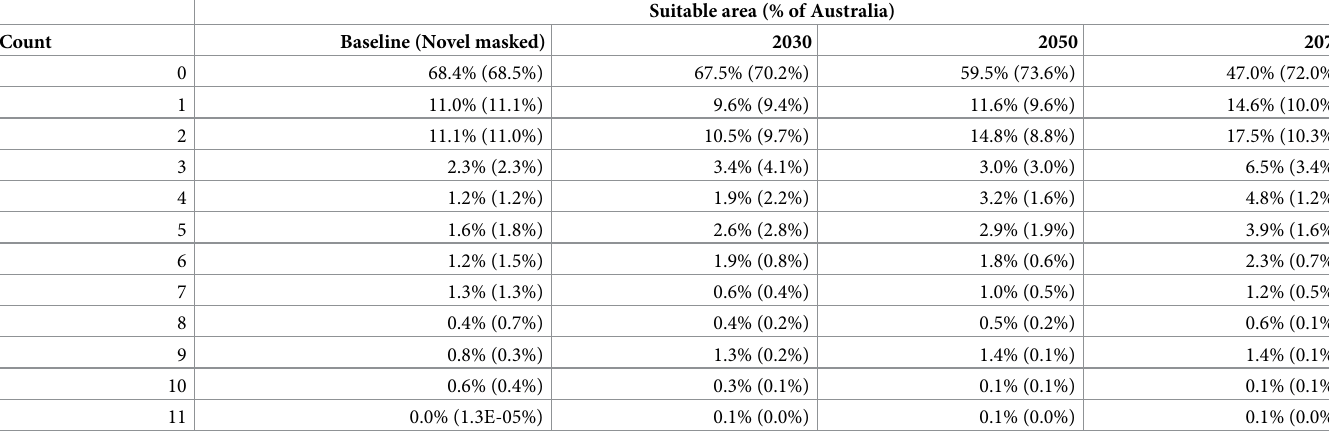
Table 2. Percentage (%) of Australia projected to be suitable for the 11 fruit fly species considered in this study, under baseline (1960–1990) and future climates.